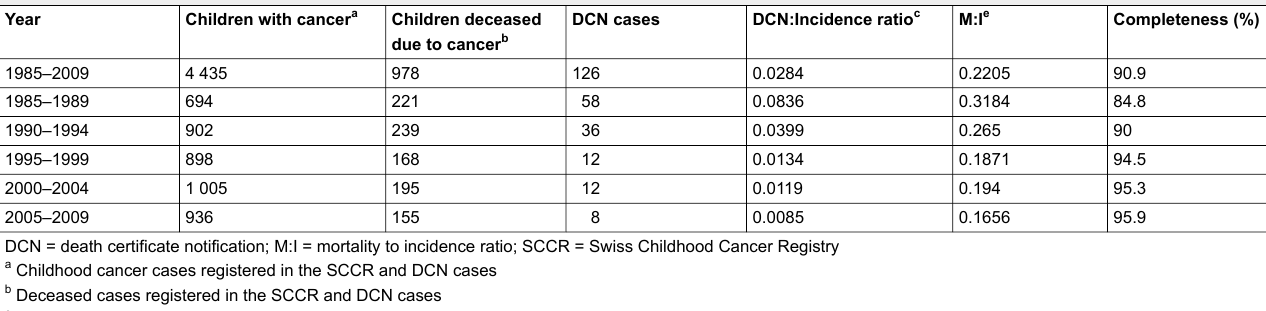
Table 4: Completeness of the Swiss Childhood Cancer Registry during different time periods, calculated using the DC-M:I